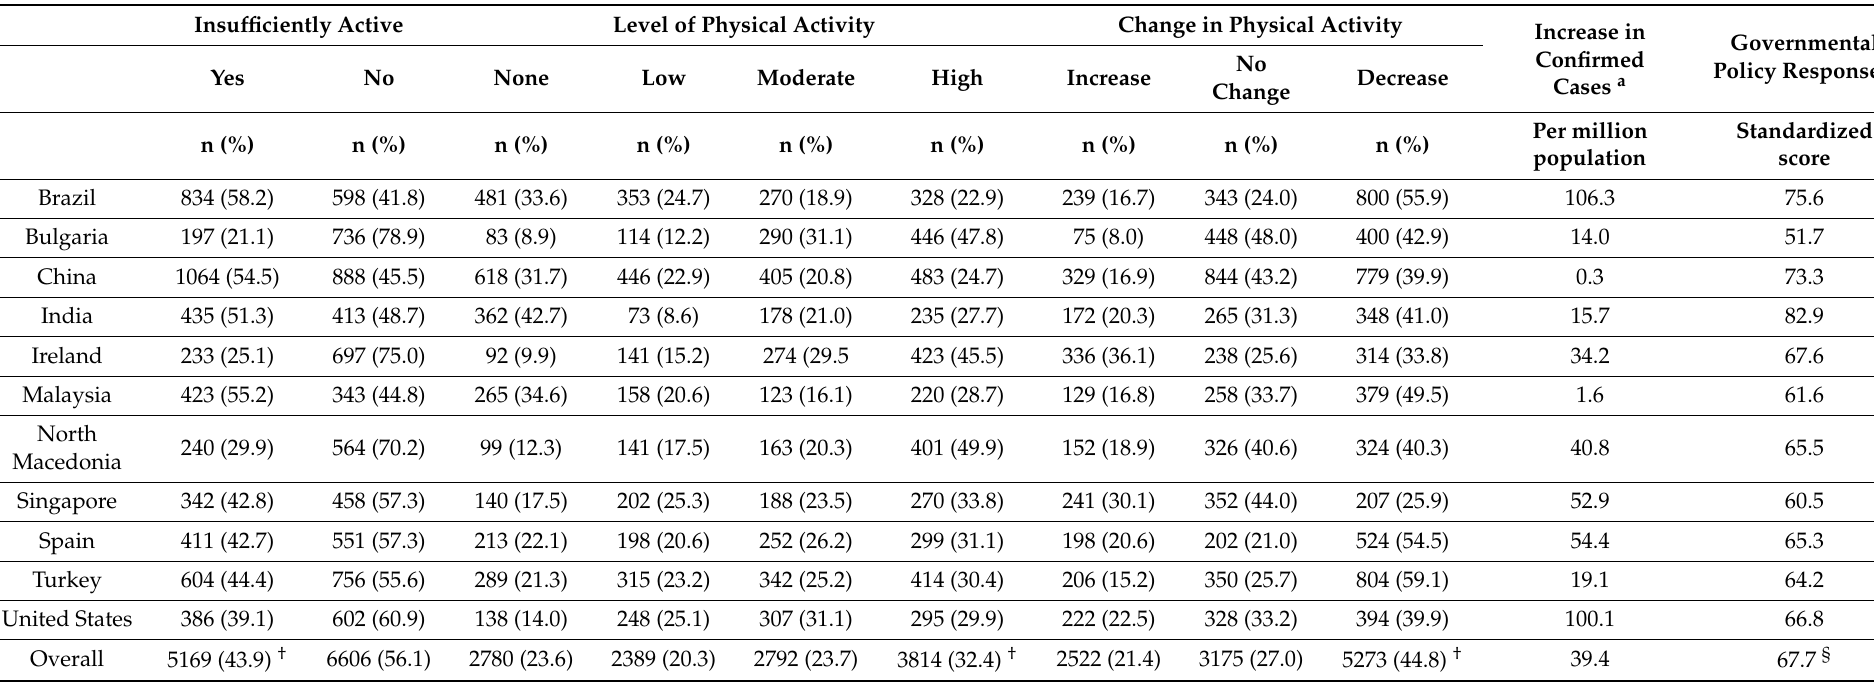
Table 2. Country-level COVID-19 risk factors and physical activity undertaken during lockdown, by 11 participating countries (n = 11,775). Insufficiently Active Level of Physical Activity Change in Physical Activity Increase in